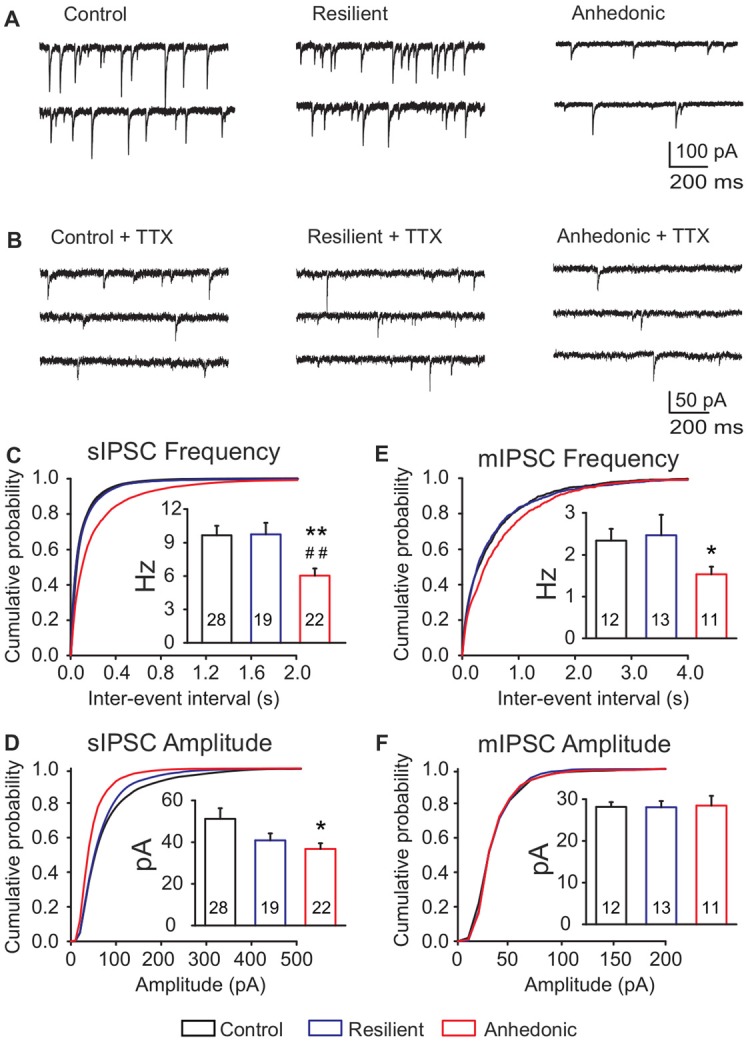
Deficit of GABAergic synaptic neurotransmission in the medial prefrontal cortex (mPFC) of anhedonic rats. Whole-cell patch-clamp recordings of spontaneous inhibitory postsynaptic currents (sIPSCs) (A) and miniature inhibitory postsynaptic currents (mIPSCs) (B) from layer II–III pyramidal neurons in the ventral mPFC. (C) Cumulative probability plot showing altered distribution of sIPSC inter-event intervals in anhedonic rats (Kolmogorov-Smirnov test, p < 0.05). Insert in (C) Anhedonic rats had reduced mean frequency of sIPSCs. (D) Cumulative probability plot displaying altered distribution of sIPSC amplitudes in the anhedonic rats (Kolmogorov-Smirnov test, p < 0.05). Insert in (D) Anhedonic rats had reduced amplitudes of sIPSCs. (E) Cumulative probability plots indicating altered distribution of mIPSC inter-event intervals in anhedonic rats (Kolmogorov-Smirnov test, p < 0.05). Insert in (E) Anhedonic rats had reduced frequency of mIPSCs. (F) Cumulative probability plot showing similar distribution of mIPSC amplitudes in all groups. Insert in (F) Mean mIPSC amplitudes were similar between the groups. Data are mean ± SEM. *p < 0.05, **p < 0.01 vs. control group; ##p < 0.01 vs. the resilient group. The numbers of examined neurons are shown in the columns.